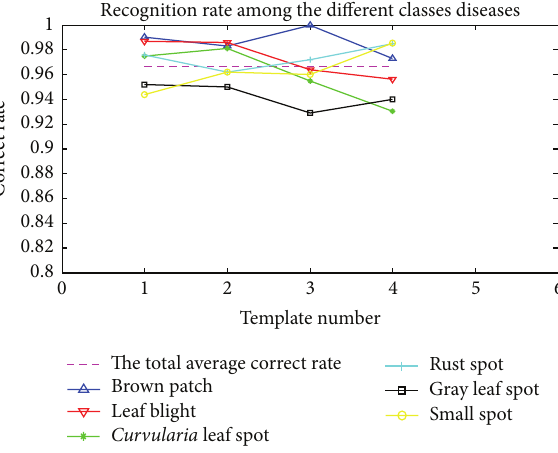
Figure 17: Recognition rate among the different classes